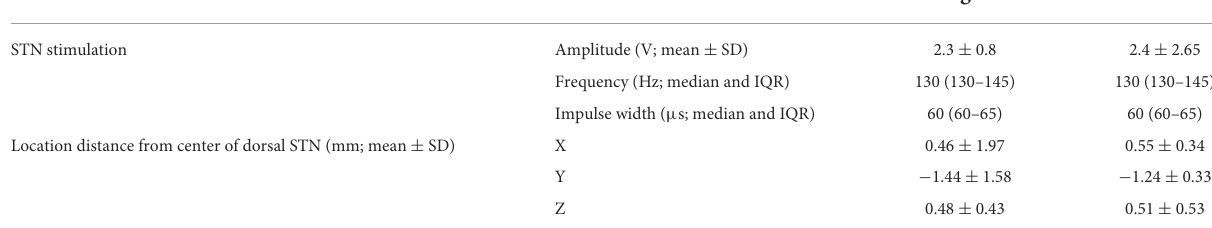
TABLE 2 Parameters of the stimulation and distance of the active contact from the motor center of the dorsolateral STN. Feature